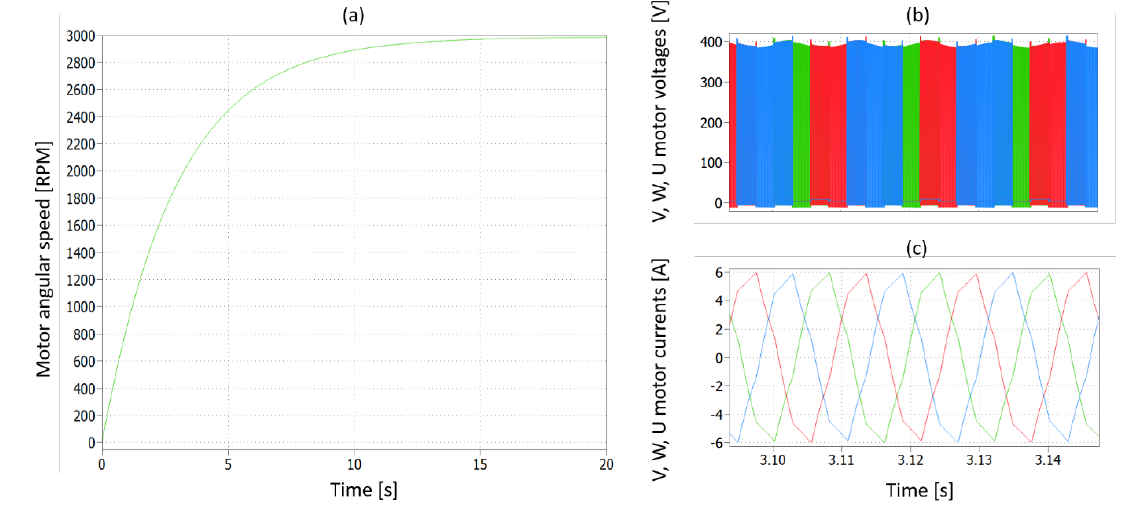
Figure 8. Free-fault simulation results.